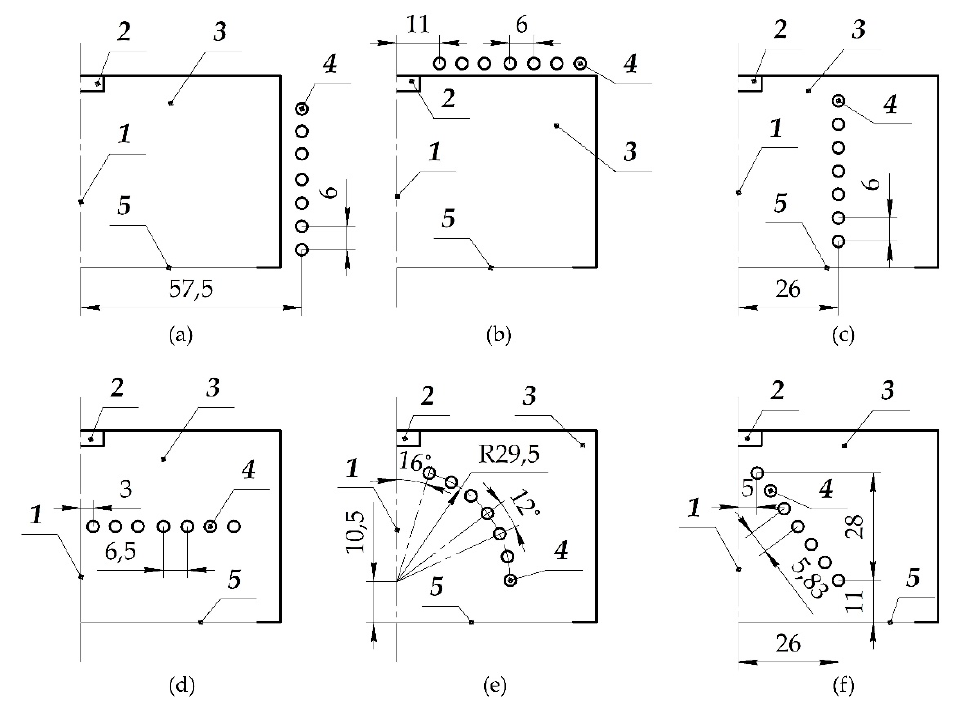
Figure 1. The considered configurations of antenna location in the ion injector (1 is the axis of symmetry; 2 is the gas distributor; 3 is the discharge chamber; 4 is the antenna turns; 5 is the ion- extraction system): ( a ) side antenna; ( b ) end antenna; ( c ) internal cylindrical antenna; ( d ) internal flat antenna; ( e ) internal hemispherical antenna; ( f ) internal conical antenna.